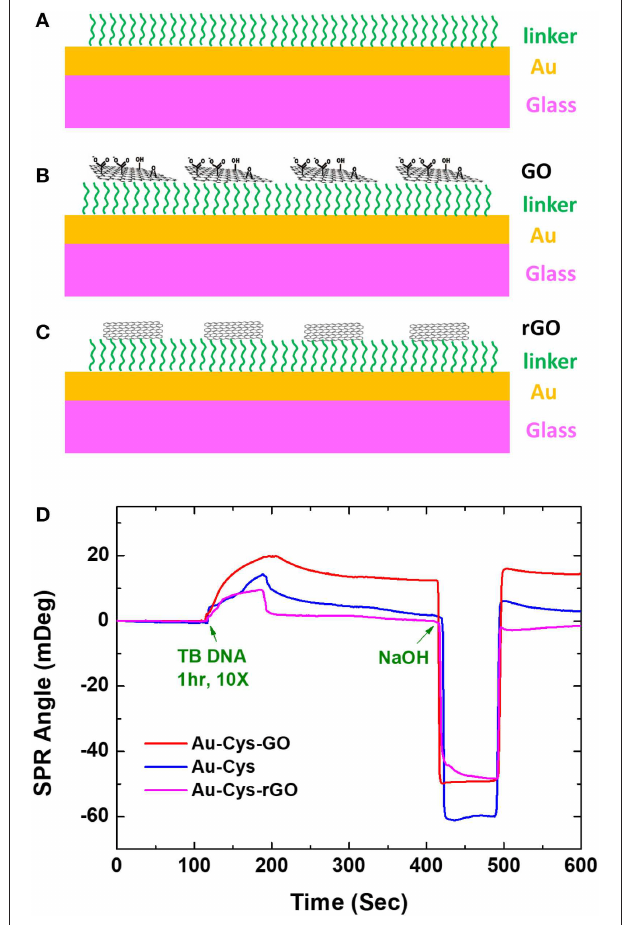
FIGURE 2 | Three fabricated chips. (A) Conventional chip. (B) GO-SPR chip. (C) rGO-SPR chip. (D) SPR sensogram on conventional chip, GO-SPR chip, and rGO-SPR chip. Figures (A–D) were reproduced from Chiu et al. (2012) with permission from the SPIE. Copyright 2012,